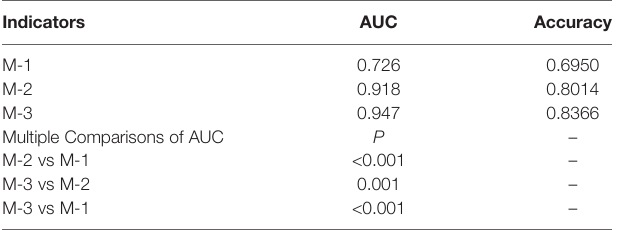
TABLE 7 | Comparisons among different indicators. Indicators